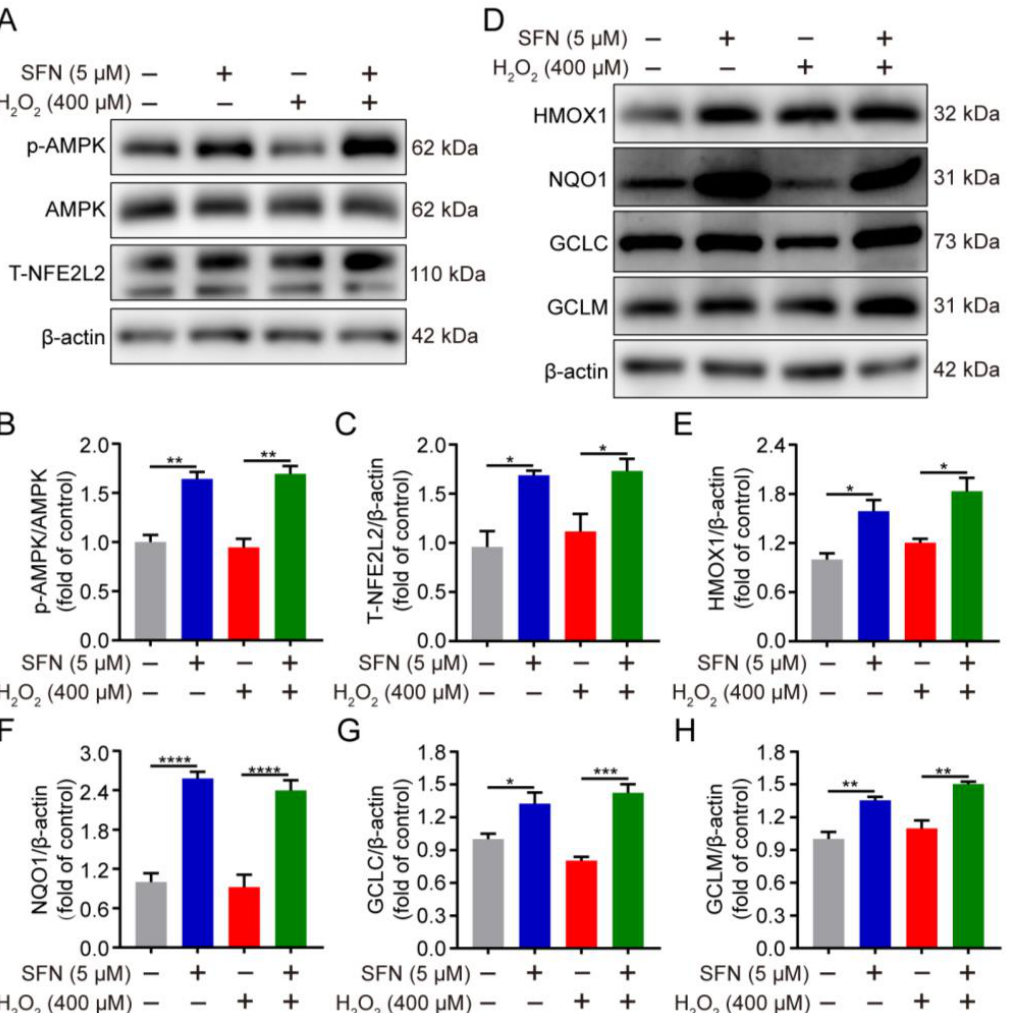
Figure 4. SFN activated the AMPK/NFE2L2 signaling pathway in H 2 O 2 -induced GMECs. Cells